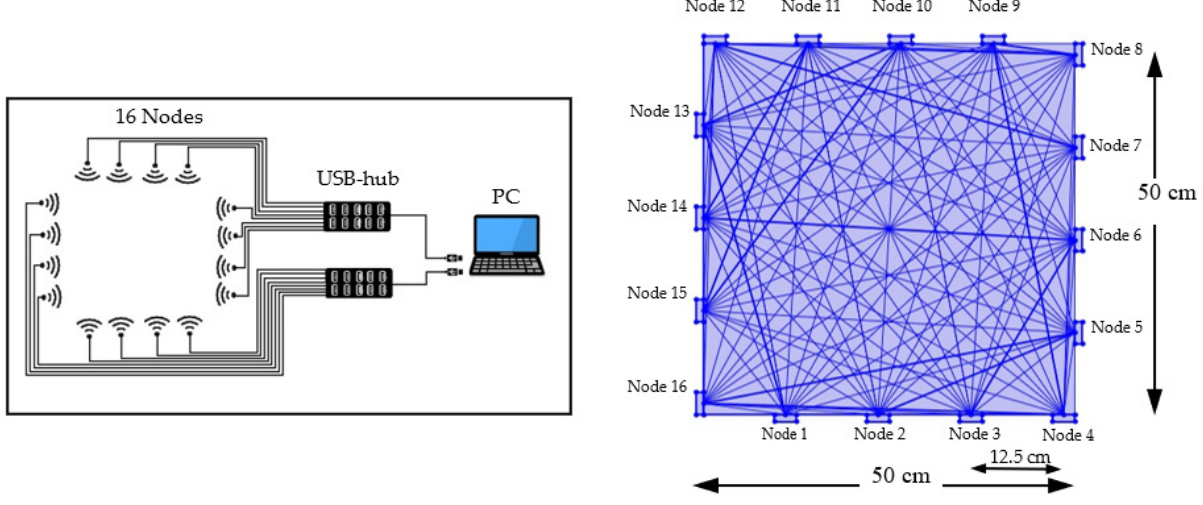
Figure 4. RTI wiring diagram and Wi-Fi mesh Signal illustration.